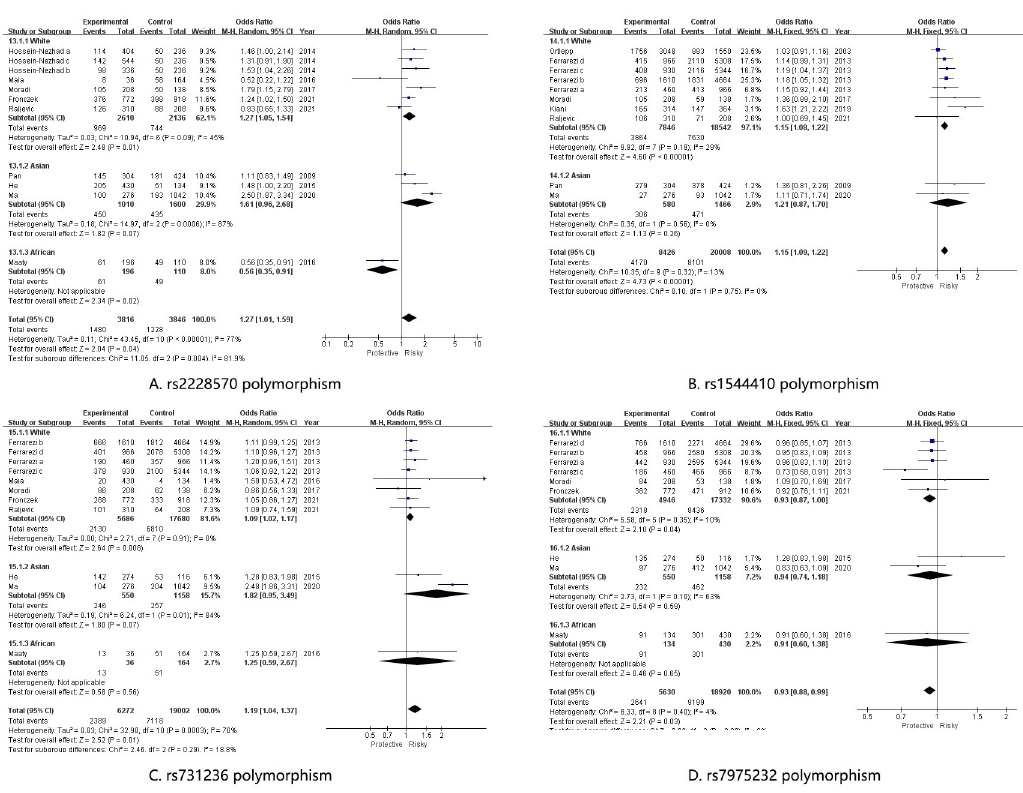
Fig 2. Forest plot of CAD risk associated with the VDR polymorphism in the subgroup analysis stratified by race. A: rs2228570 polymorphism; B: rs1544410 polymorphism; C: rs731236 polymorphism; D: rs7975232 polymorphism. CAD = Coronary artery disease, VDR = vitamin D receptor, OR = odd ration, CI = confidence interval.